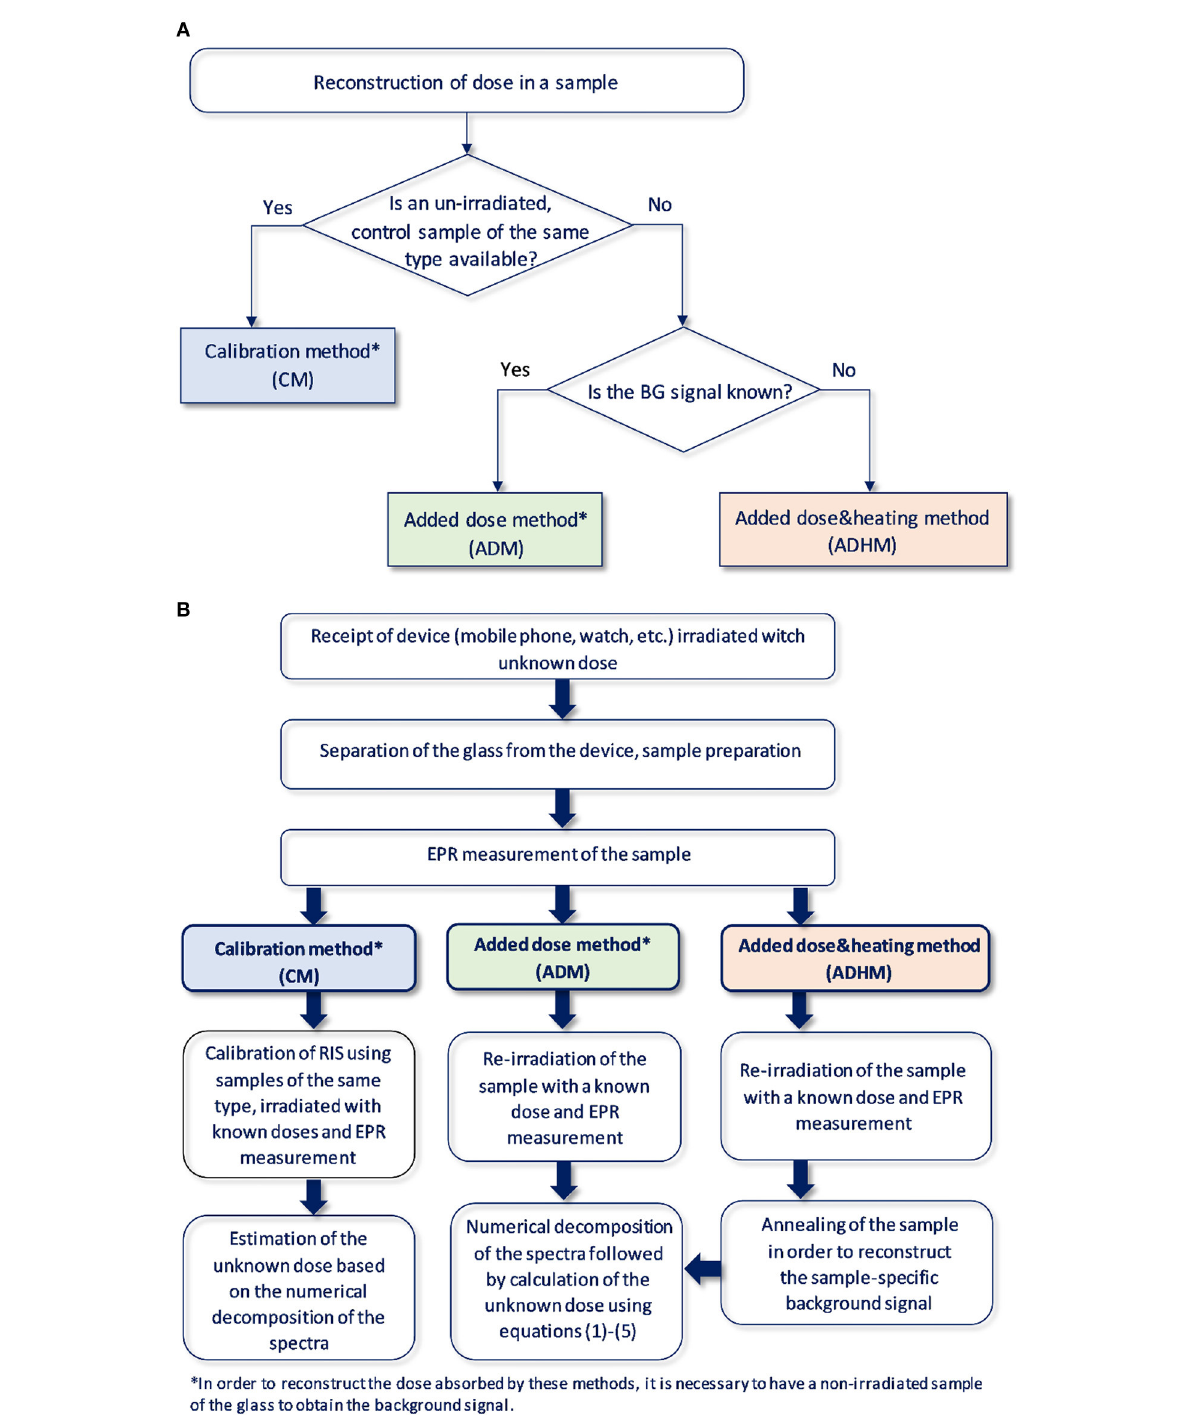
FIGURE2 (A) Logical diagram for selection of the method of reconstructing the absorbed dose in the glass depending on the available information and the tested material. (B) Schematic illustration of the dose reconstruction